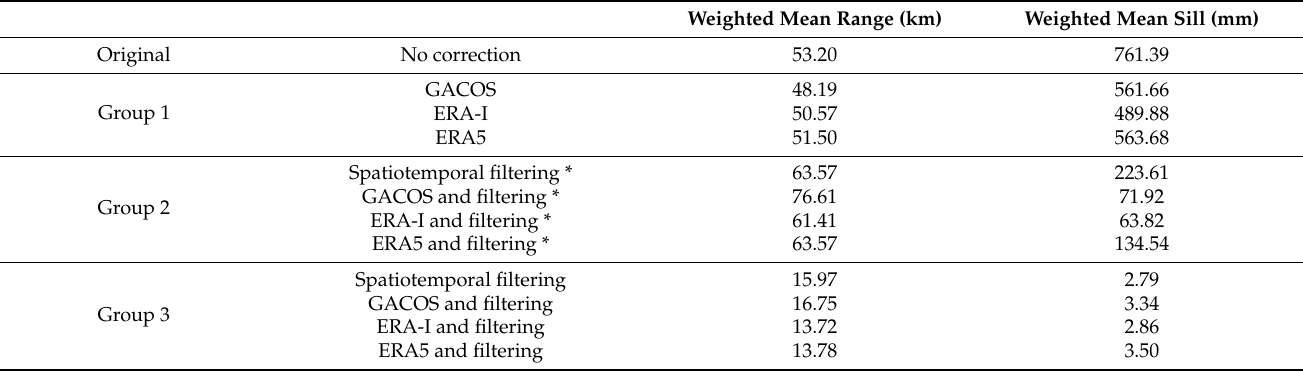
Table 4. The model-fitted mean decorrelation range and sill of semi-variograms before and after tropospheric corrections. Entries denoted by ‘*’ preserve the primary TOE in the interferograms. Weighted Mean Range (km)